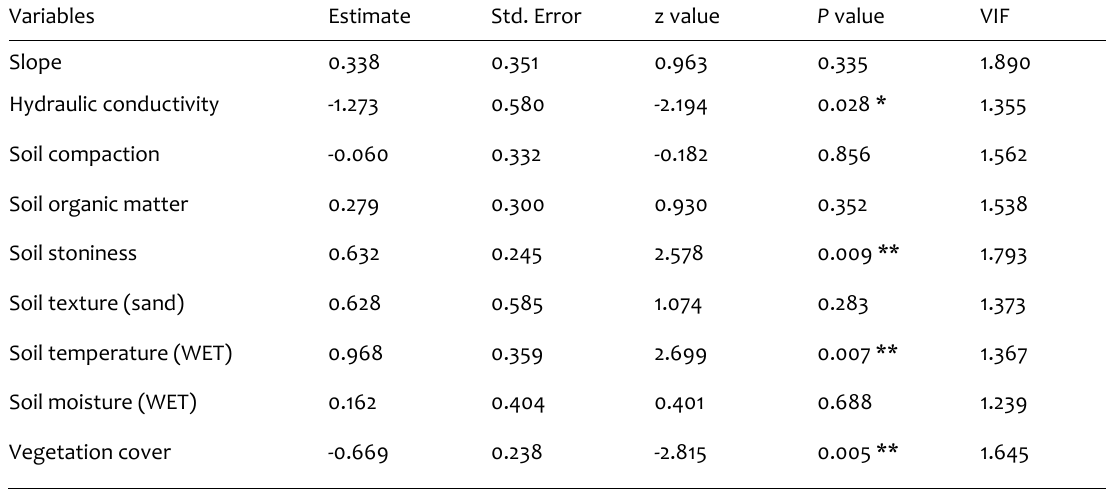
Table 2: GLMM analyses of soil variables for 2020 only. The variables which had significant correlation with peak nest density were hydraul ic conductivity, soil stoniness, soil temperature and vegetation cover. Significant variables: 0 ‘***’ / 0.001 ‘**’ / 0.01 ‘*’ / 0.05